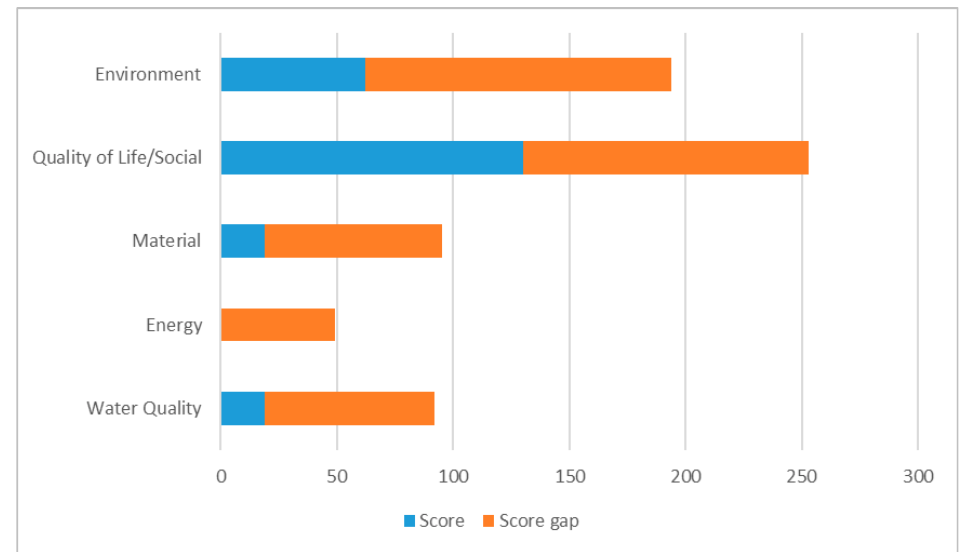
Figure 3. Points achieved in relation to applicable points across each category of the triple bottom line used in this research for the Envision rating system for Project 1.